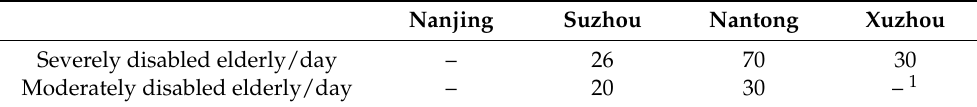
Table 5. Differences in care subsidies in selected areas